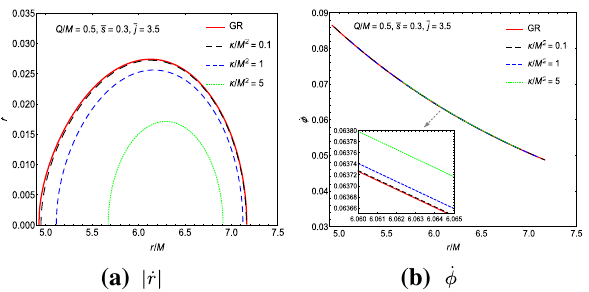
Fig. 4 The shapes of the radial velocity ˙ r and angular velocity ˙ φ for different κ